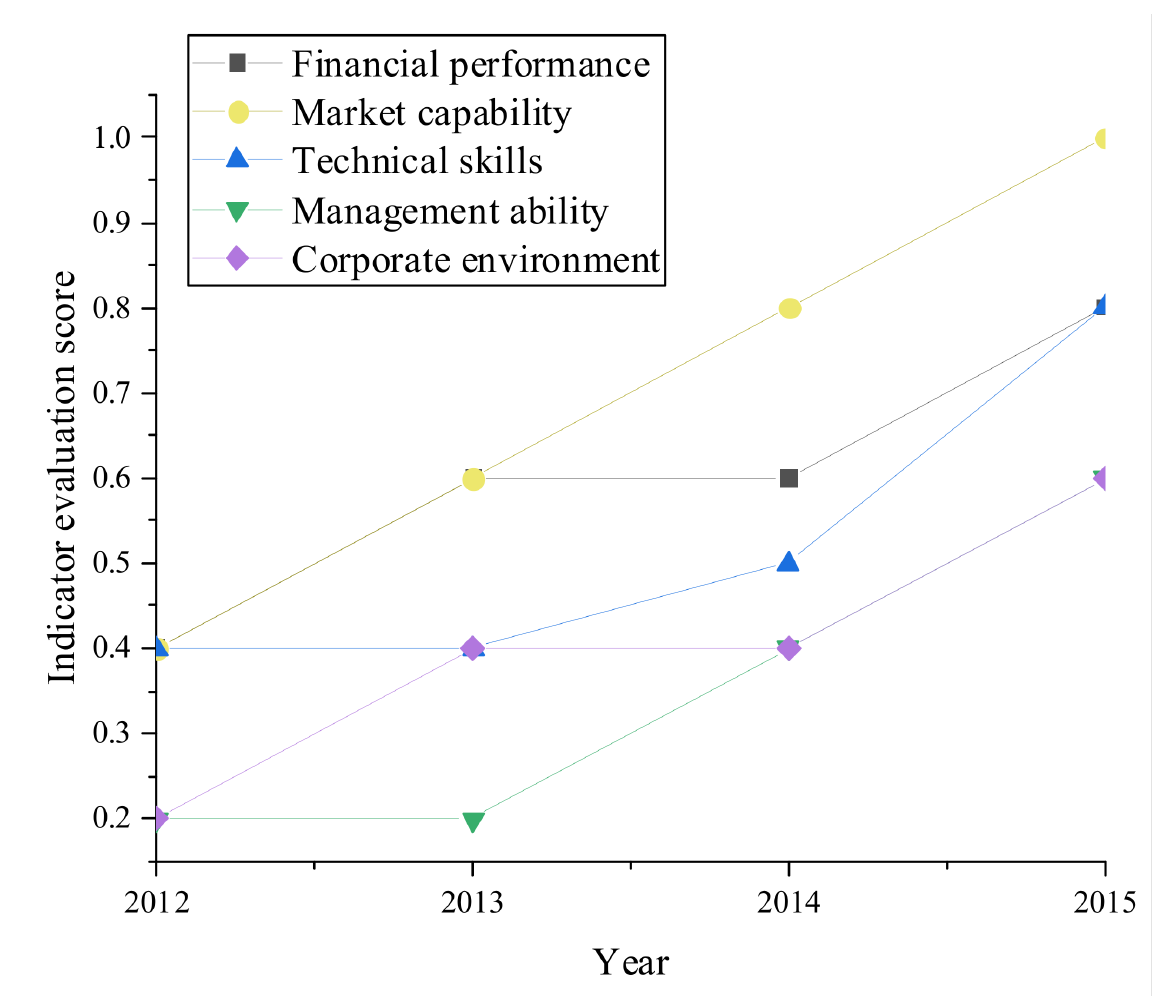
Figure 9. Changes in enterprise indexes during BYD’s